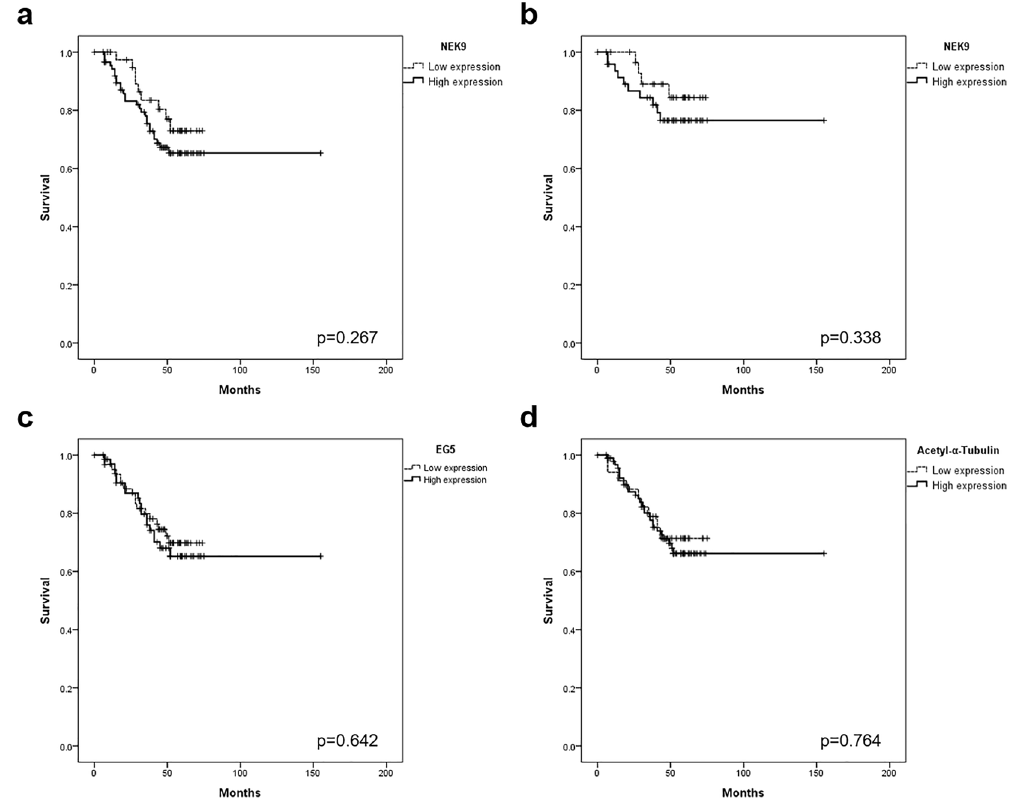
Figure 2. Kaplan–Meier survival curves for overall survival (OS) according to the expression of NEK9, EG5 or acetyl-α-tubulin. ( a ) NEK9 expression in the whole cohort (n = 136). ( b ) NEK9 expression in the M0 patient subgroup (stage III; n = 87). ( c ) EG5 expression in the whole cohort. ( d ) Acetyl-α-tubulin expression in the whole cohort. OS differences were observed between the low- and high-expression cases for these proteins, with a more distinct difference for NEK9. M0, patients with no evidence of metastasis.